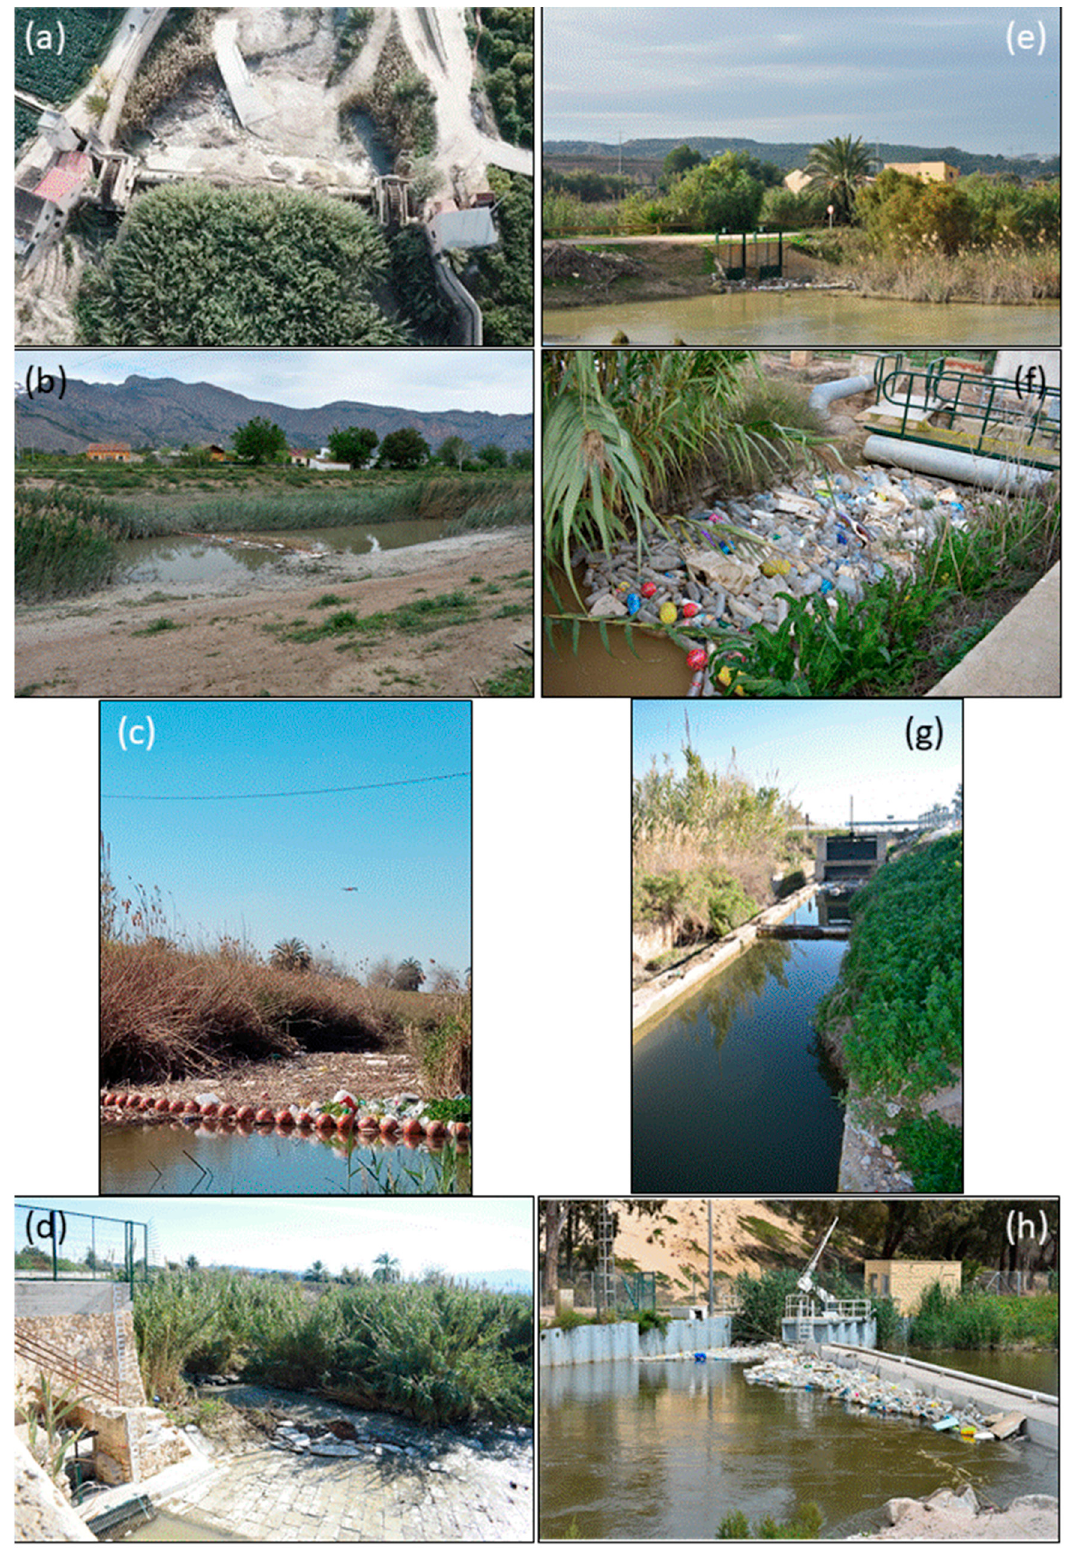
Figure 3. Sampling points. ID1, Azud de las Norias ( a ); ID2, boom at the Molino de la Ciudad ( b ); ID3, boom at Almoradí ( c ); ID4, Azud de Alfeitamí ( d ); ID5, inlet of Riegos de Levante ( e ); ID6, Acequia de Callosa ( f ); ID7, Azarbe de Cebadas ( g ); and ID8, Guardamar floating screen ( h ).